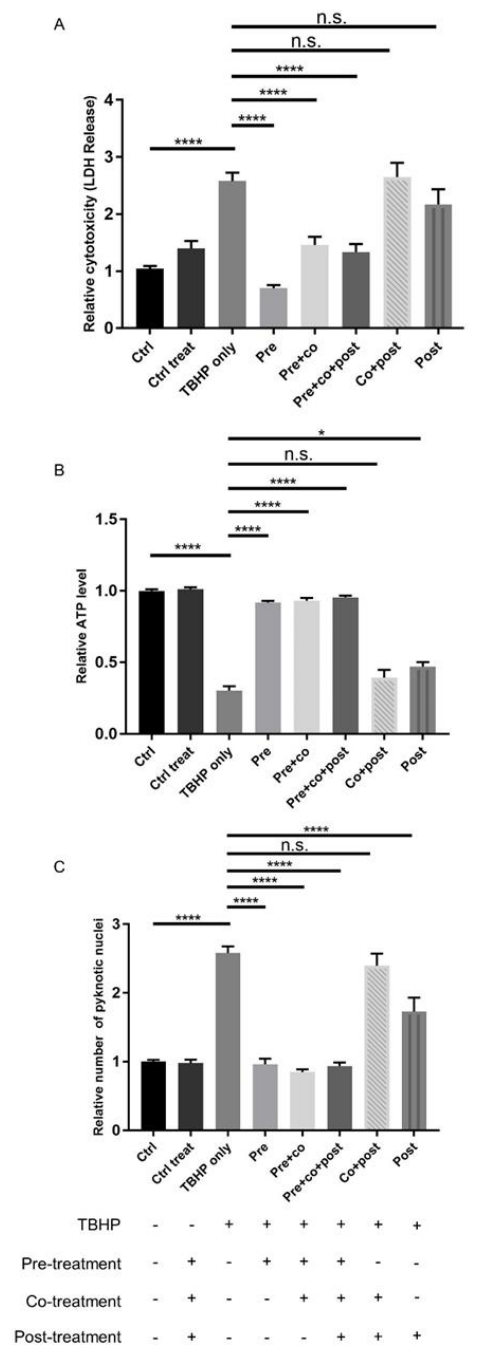
Figure 3. Effect of crocetin on TBHP-induced oxidative stress in ARPE19 cells. ARPE19 cells were treated with different protocols, and then LDH ( A ) and ATP ( B ) assays, as well as counting of pyknotic nuclei ( C ) were performed to assess the effect of these treatment protocols. The response of ARPE19 cells to crocetin can be categorized into two groups: pre-treated and non-pre-treated. LDH and ATP levels were preserved in pre-treated groups comparable to controls (-TBHP), whereas levels changed in non-pre-treated groups to a similar extent as the TBHP-only group. Quantification of condensed nuclei confirmed the protective action of pre-treatment with crocetin on TBHP stressed ARPE19 cells. The number of pyknotic nuclei were increased similar to the TBHP-only group, but not in pre-treated groups. Data are shown as mean ± S.E.M. p -value: < 0.05 (*), < 0.0001 (****) n = 4, (One-way ANOVA, Tukey’s multiple comparison test). n.s. = non